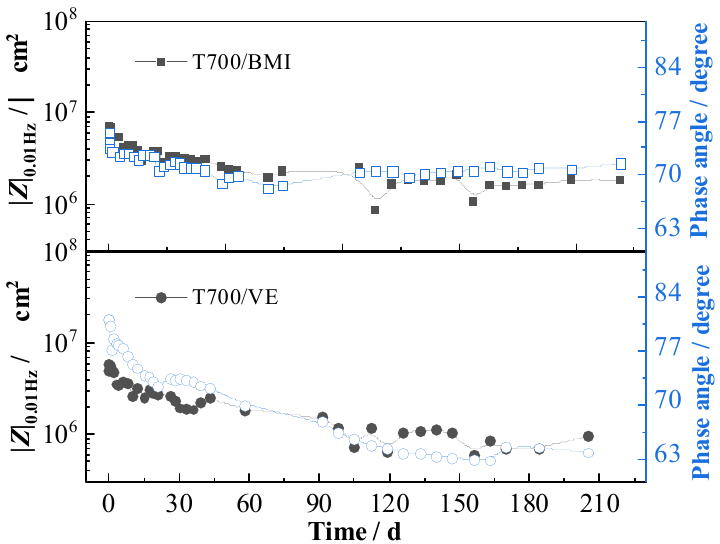
Figure 11. Variations of phase angle at 10 Hz and | Z | 0.01Hz with testing time for two composites.